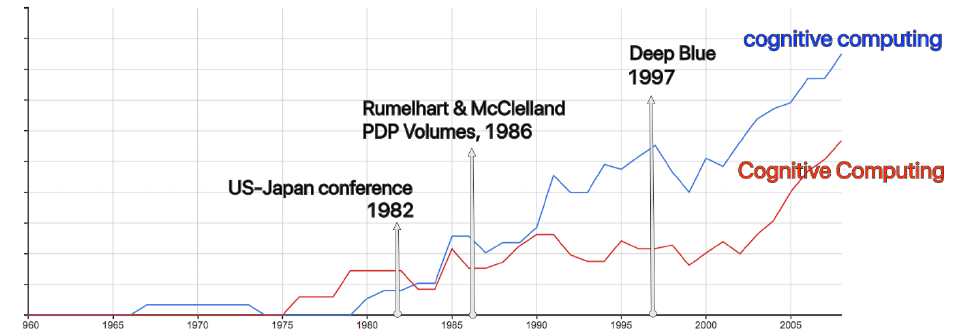
Figure 1. The use of the terms cognitive computing and Cognitive Computing according to Google’s Ngram Viewer. Several key points in the evolution of AI are also